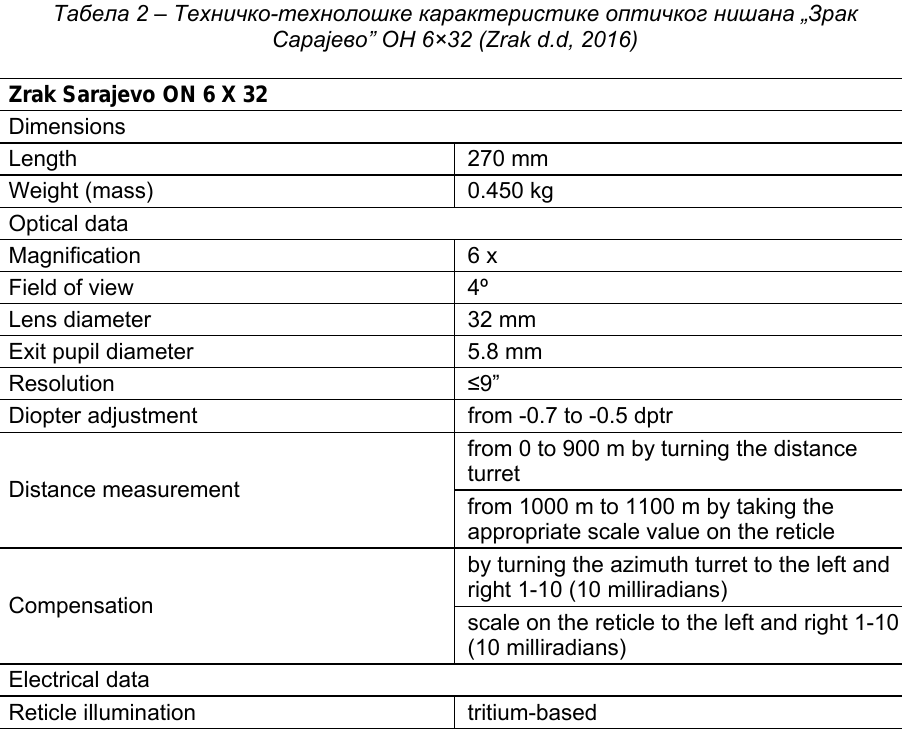
Table 2 – Technical-technological characteristics of the Zrak Sarajevo ON 6 x32 optical sight (Zrak d.d, 2016) Таблица 2 – Технико - технологические характеристики оптического прицела Табела 2 – Техничко - технолошке карактеристике оптичког нишана „